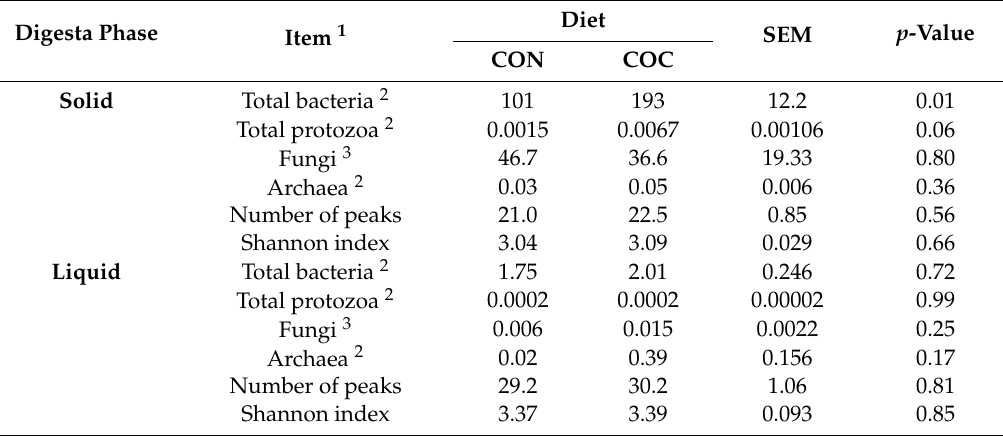
Table 4. E ff ects of partially replacing maize silage and barley straw in a mixed diet (CON) by crude olive cake (COC) on microbial abundance and bacterial diversity in solid and liquid phases of Rusitec fermenters ( n =